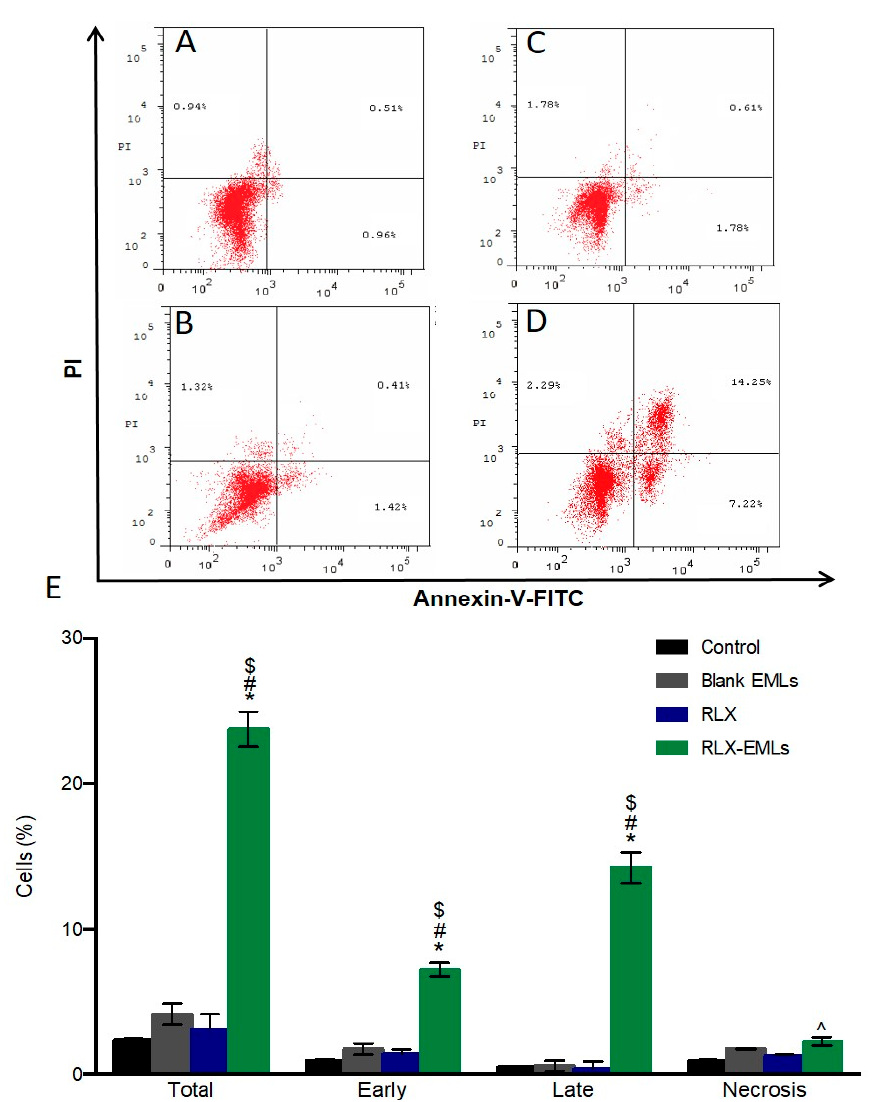
Figure 4. Effect of RLX-EMLs or RLX on MCF-7 apoptosis profile using annexin V/PI staining. ( A ) control, ( B ) blank EMLs, ( C ) RLX, and ( D ) RLX-EMLs. ( E ) graphical presentation of each phase (early apoptotic, late apoptotic, total apoptotic, and dead cells). All data are expressed as the mean ± SE of three independent experiments. * p < 0.05 considered significantly different from the control. $ p < 0.0001 considered significantly different from RLX, # p < 0.0001 considered significantly different from blank EMLs. ˆ p < 0.05 considered significantly different from the control, RLX, or blank